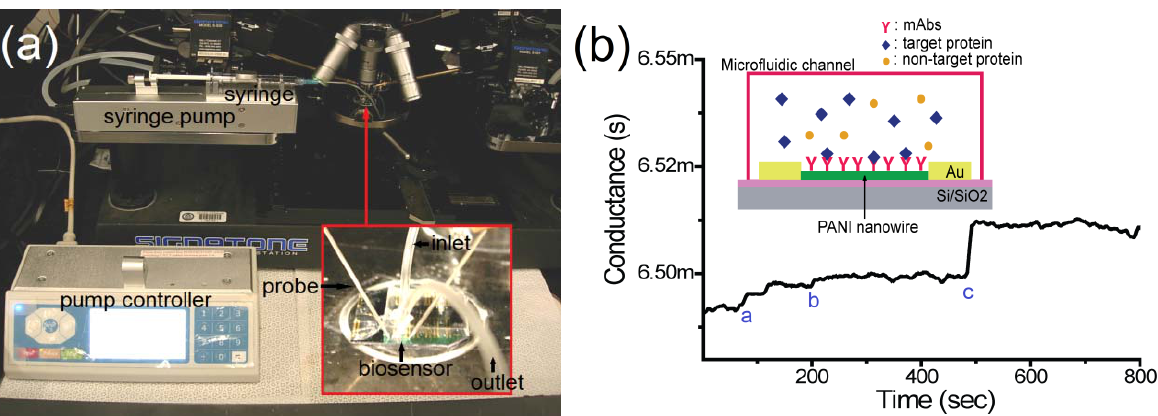
Figure 1. An illustration and the experimental set-up of the single polyaniline (PANI) nanowire biosensor to detect cardiac biomarkers. ( a ) The experimental setup; the microfluidic channel is adhered on the nanowire biosensor and the nanowire biosensor chip is mounted on a probe station connected to the semiconductor analyzer and syringe pump with inlet and outlet; ( b ) The conductance change in the single PANI nanowire-based biosensor is monitored. The injection of PBS (mark a), BSA (mark b), and cardiac biomarker (mark c) shows the different changes of